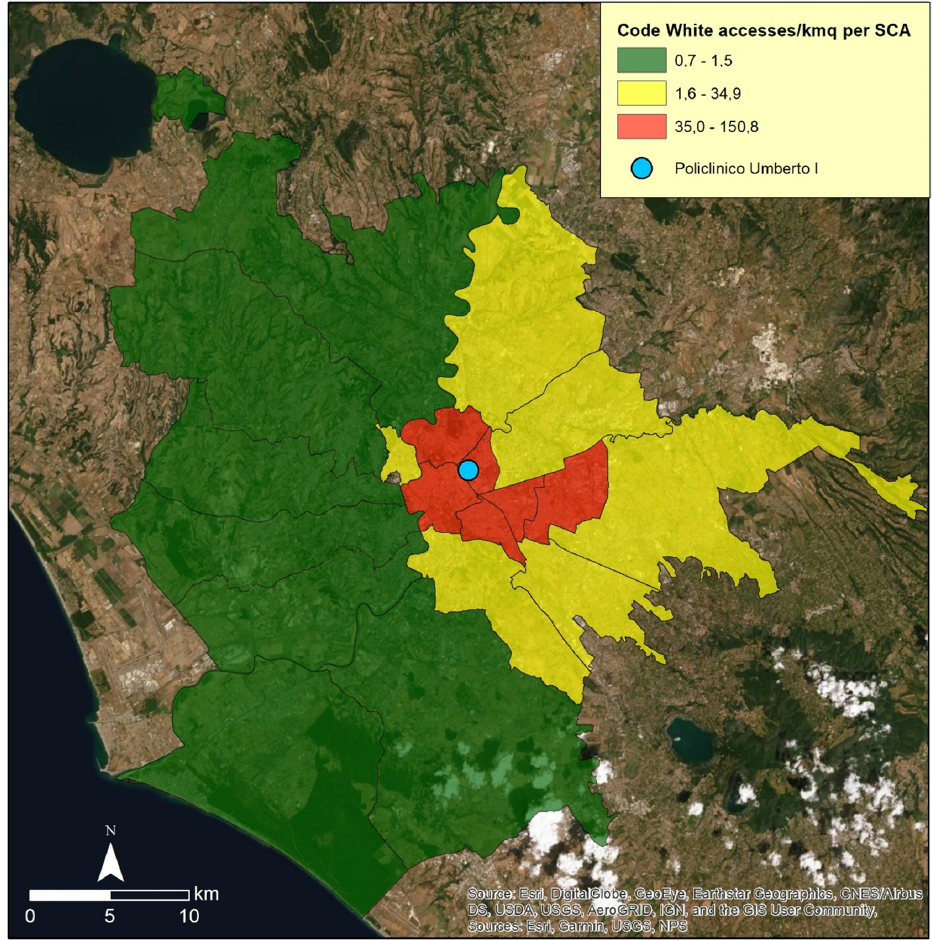
Figure 11. Accesses in code white recorded by the Policlinico Umberto I emergency room in relation to the surface, with data aggregated on the basis of sub-municipal areas. Source: authors’ elaboration.